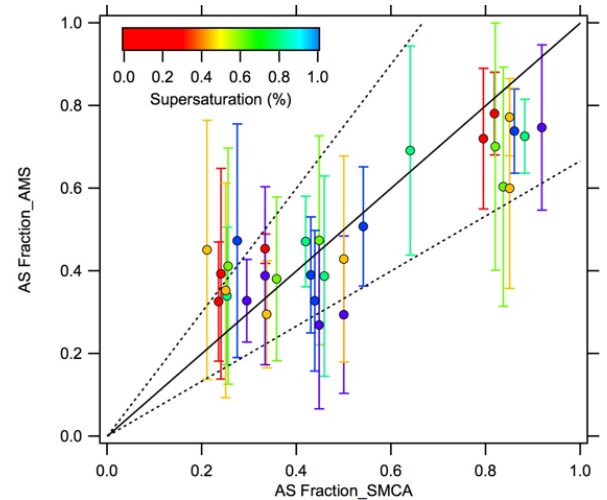
Figure 6. Modifying activation diameters. Plateau heights derived from AMS data vs. SMCA for CCNC supersaturation from 0.2% to 1.2%. Dashed lines indicate 50% uncertainty (1 : 1 . 5 and 1 . 5 :